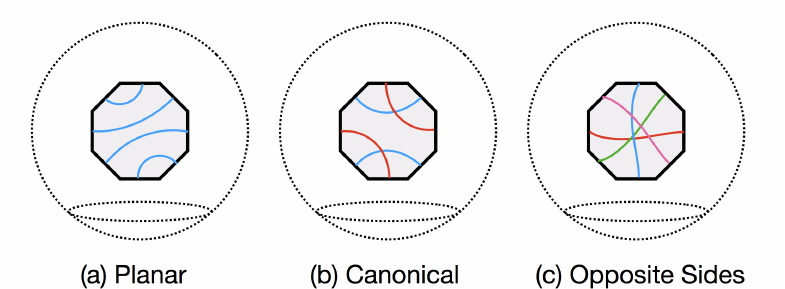
Figure 10. Backside (or chord diagram ) views of three polygonal schemata: ( a ) A planar schema; ( b ) a canonical schema; and ( c ) a schema where opposite sides are identified.